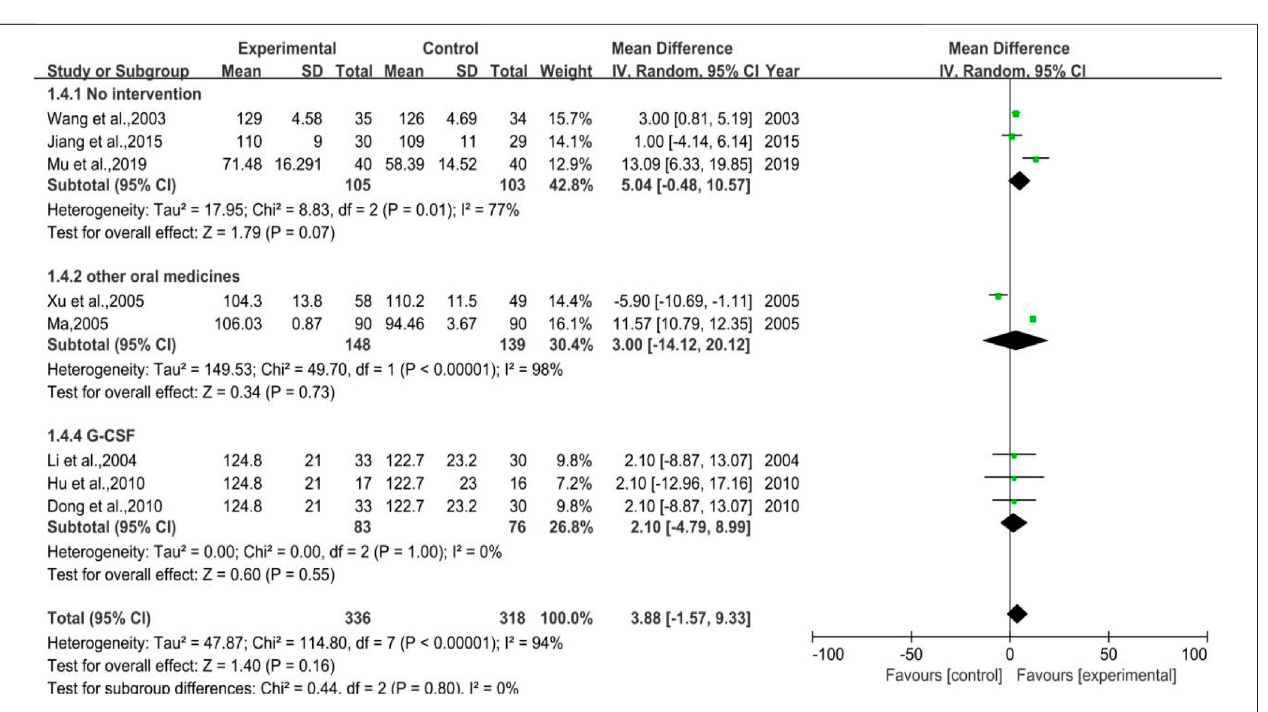
FIGURE 6 | The forest plot of hemoglobin count in preventive medication.